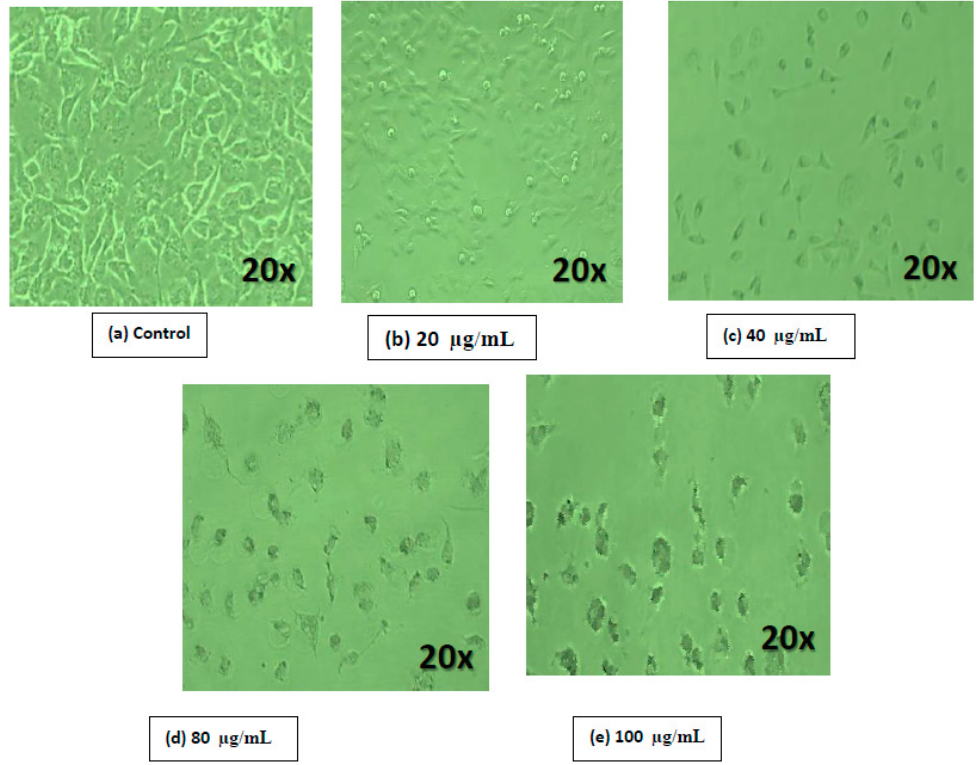
Figure 7. Morphological changes of breast cells when treated with GO-Ag ( a ) control ( b ) 20 µg/mL ( c ) 40 µg/mL ( d ) 80 µg/mL ( e ) 100 µg/mL.